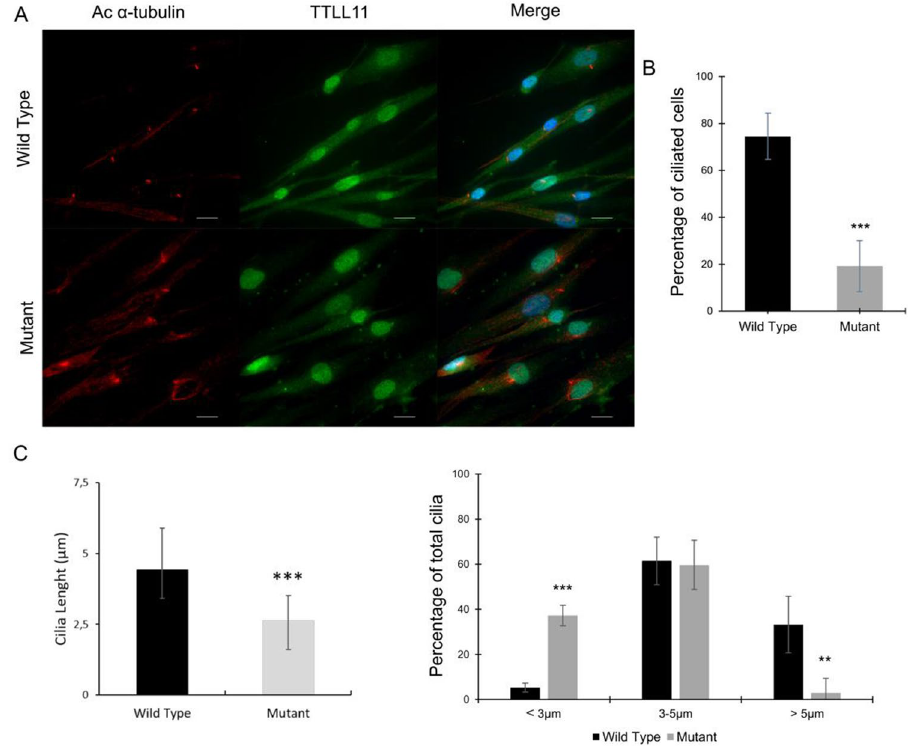
Figure 3. WT and mutant TTLL11 protein expression after starvation. ( A ) WT (DE0194) and mutant (DE0193) fibroblasts were treated with medium without FBS for 24 h. Cells were stained with immunofluorescence for acetylated α -Tubulin (red), TTLL11 (green) and DAPI (blue). Scale bar 20 μm. ( B ) Graphical representation of the percentage of TTLL11 mutant ciliated fibroblasts compared to WT fibroblasts (DE0194) n = 660. ( C ) Graphical representation of mean cilia length for TTLL11 mutant ciliated fibroblasts compared to WT fibroblasts (left panel) and distribution of ciliated cells based on cilia length: < 3 µ m; 3–5 µ m; > 5 µ m (right panel); n = 185. Values shown as mean ± SD, the difference with controls was examined by unpaired, two-tailed Student’s t-test, *P ≤ 0.05, **P ≤ 0.01, ***P ≤